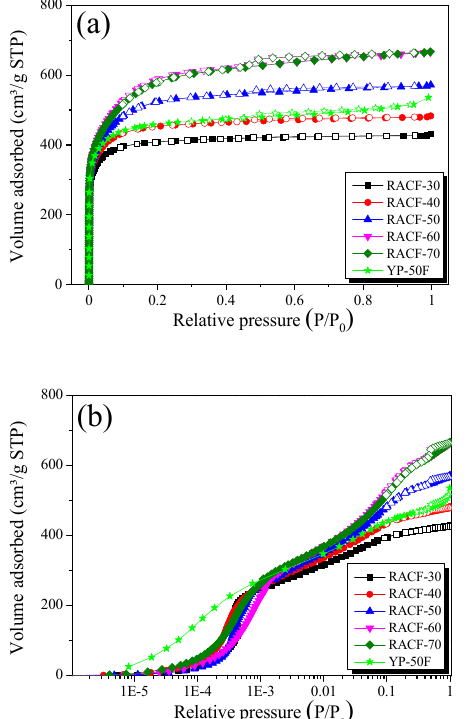
Figure 3. SEM images of the electrode materials ( a ) YP-50F, ( b ) RACF.